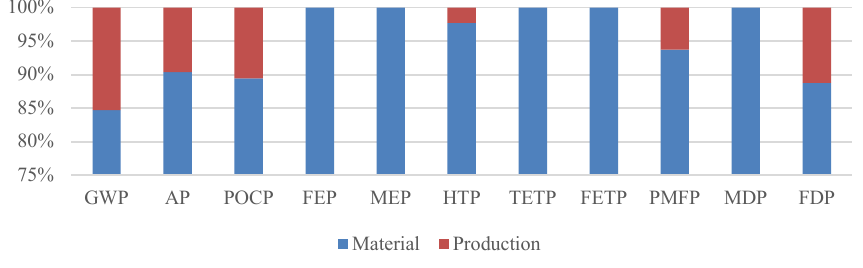
Fig. 3. Results obtained from the analysis of the life cycle of the 1 kWh of the NCM battery, in the impact categories according to the V1.11/World ReCiPe H method [15]. Chemicals that include cobalt in the cathode structure determine a greater share of metal depletion, since it is defined as a critical element [16] and worsens its position if adequate measures are not applied to reduce its use [34]. The criticality of cobalt is confirmed by all five methodologies used for the assessment of environmental impacts in the study